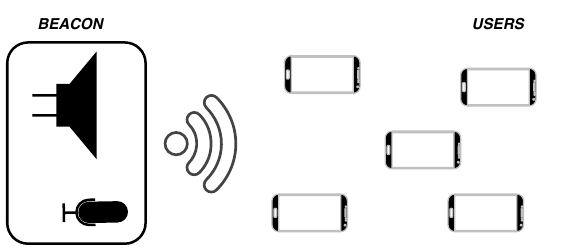
Figure 1. Reference scenario of the proposed DFCE system: broadcast beacon-to-users communication